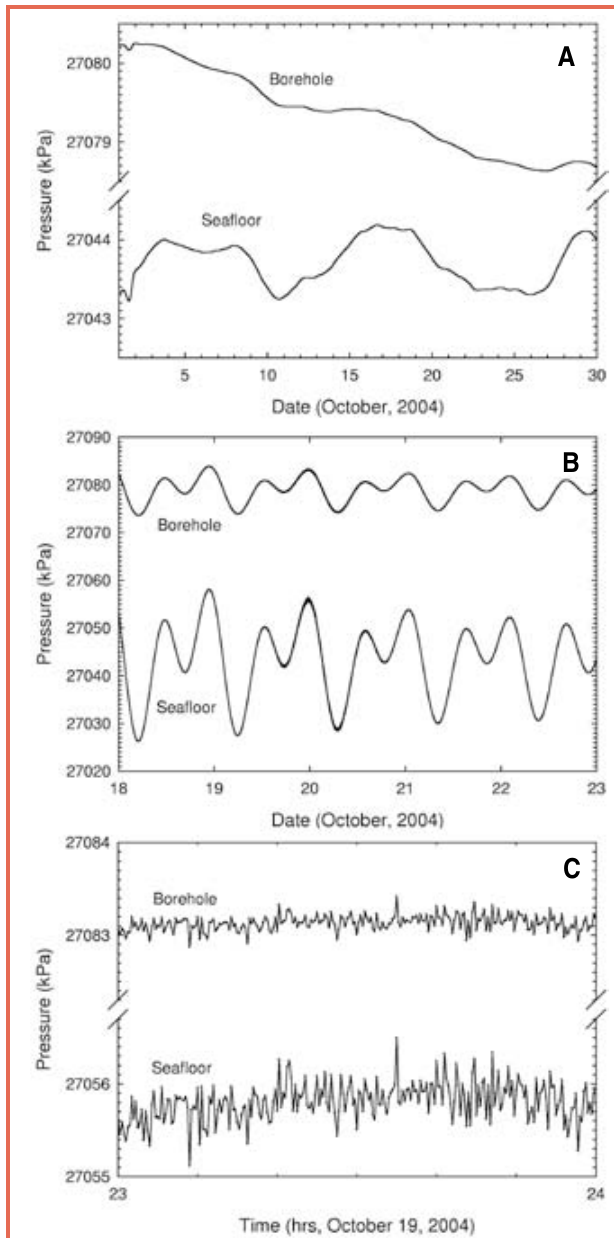
Figure 4. Typical formation-pressure response to [A] long-period, [B] tidal, and [C] infragravity sea-surface wave loading observed with a high resolution monitoring instrument at ocean crustal Site